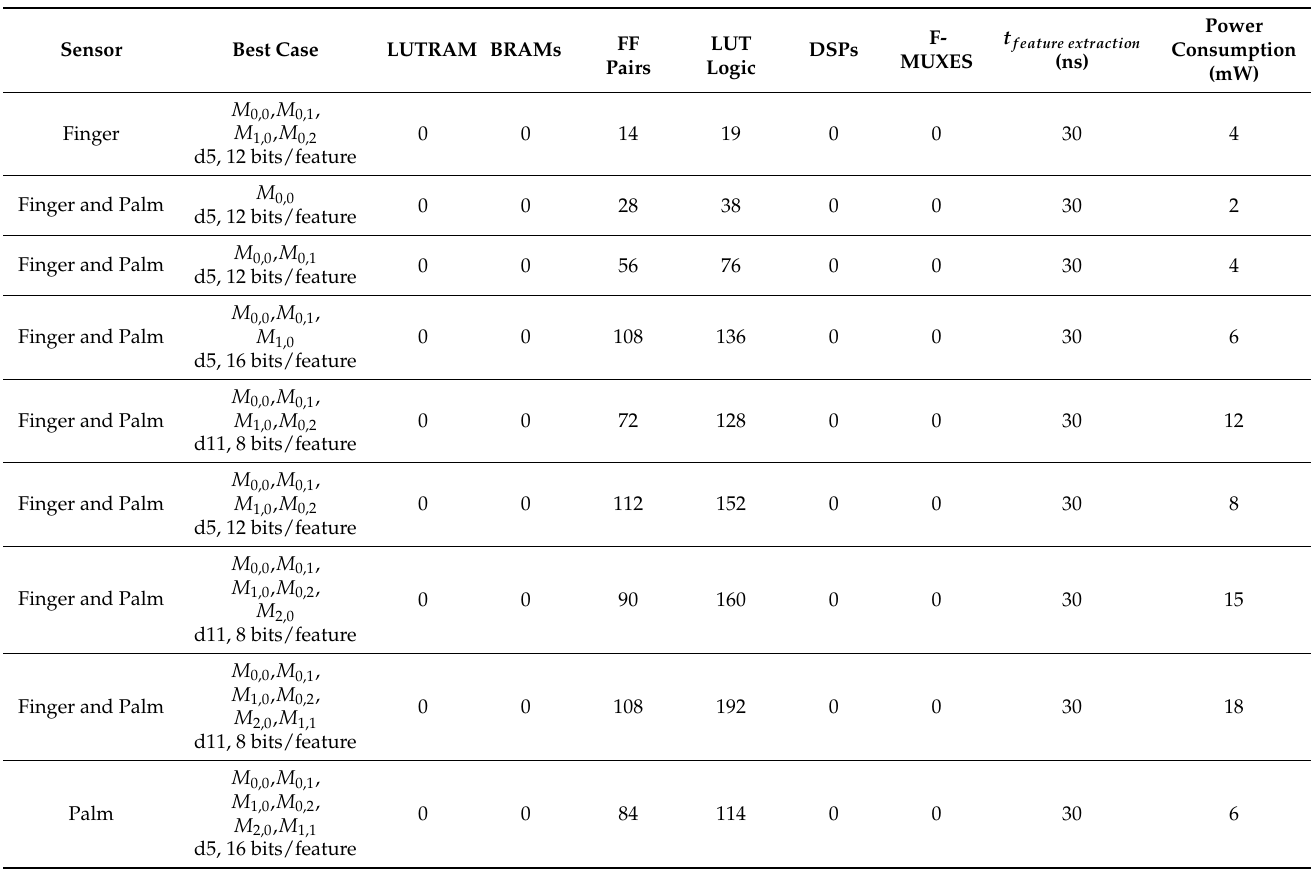
Table 4. Performance data for the implementation of the feature extraction without PCA (VHDL features computing module in Figure 7), as provided by the real Vivado IDE ® Utilization Report. The last two columns are the input–output delay of the module (in ns), and its power consumption (in